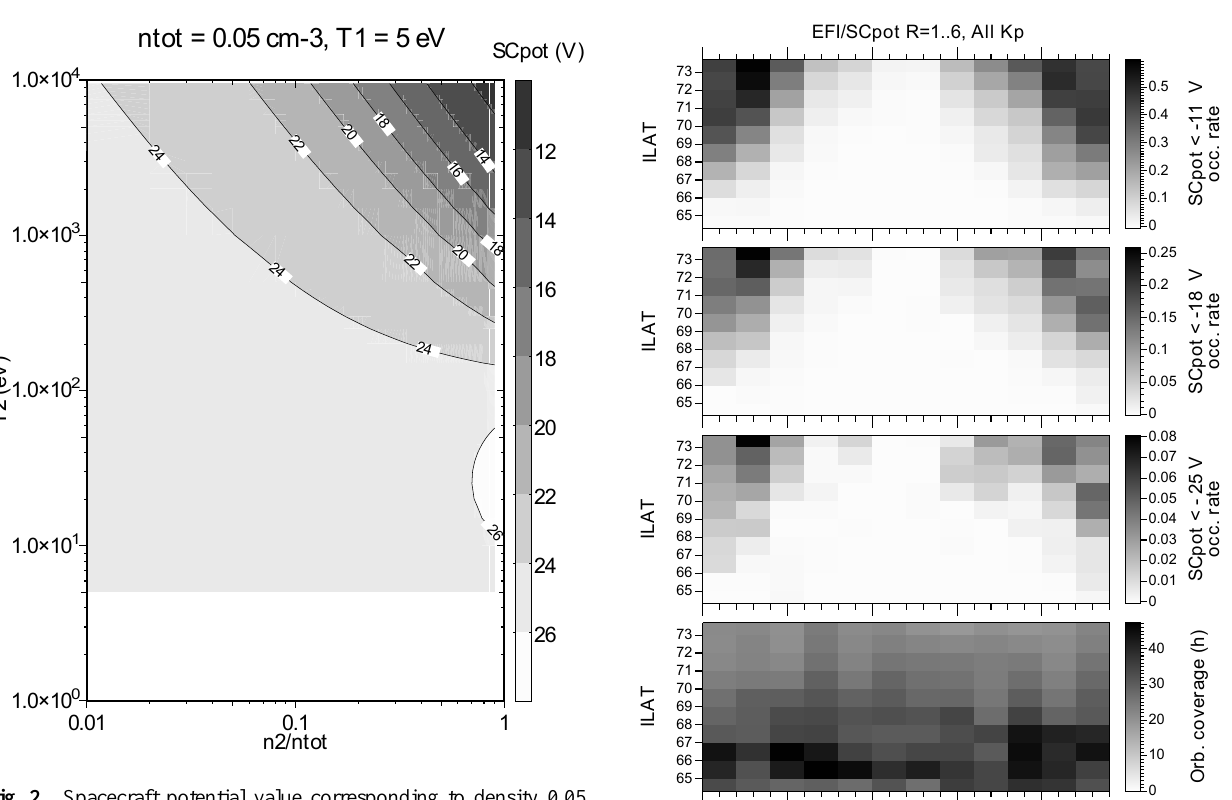
Fig. 2. Spacecraft potential value corresponding to density 0.05 cm − 3 in a model containing two Maxwellian electron populations, called hot and cold. The horizontal axis is the hot versus total den- sity ratio and the vertical axis is the hot component temperature. The cold component temperature is set to 5 eV.